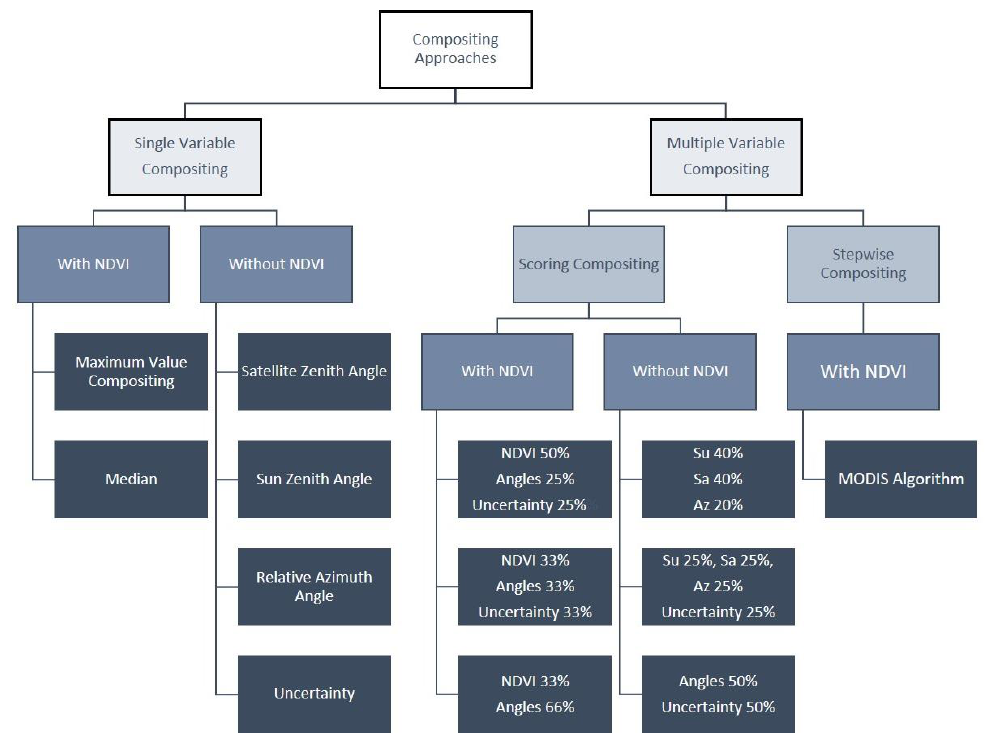
Table 1 for the method names, abbreviations, formulas, and underlying considerations.